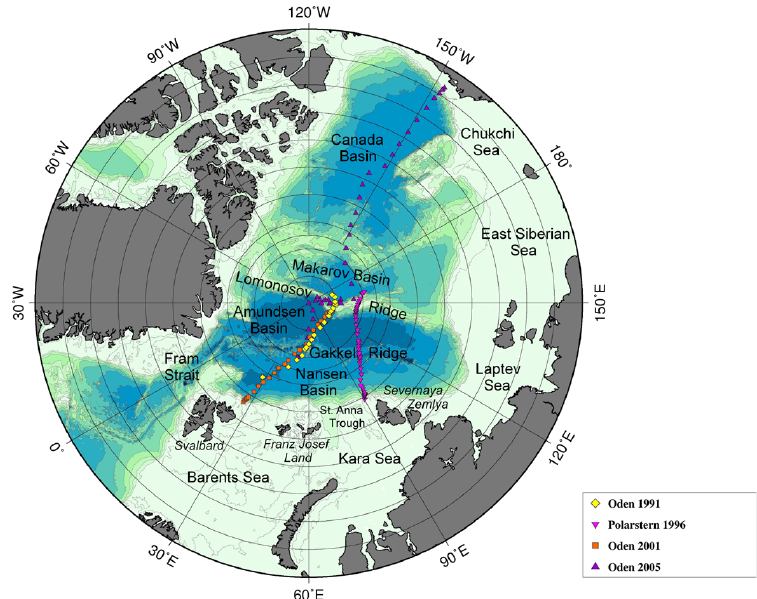
Fig. 2b. The positions of the stations from Oden 1991, Polarstern 1996, Oden 2001 and Oden 2005 used in this